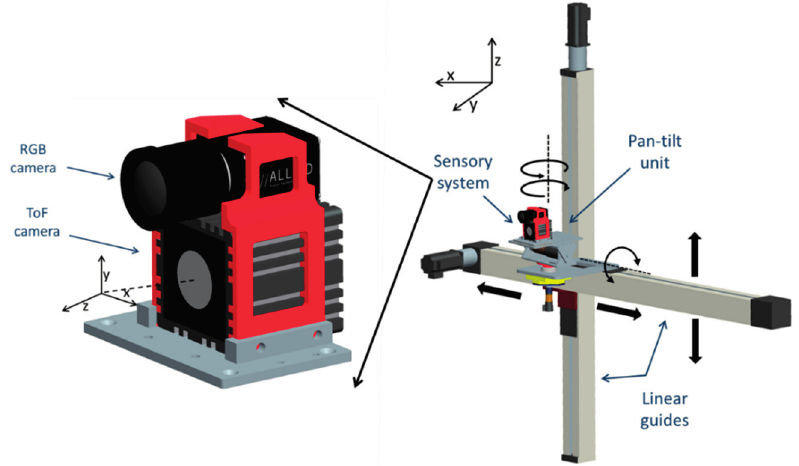
Figure 1. Sensory system configuration. The sensory rig consists of a ToF camera and a